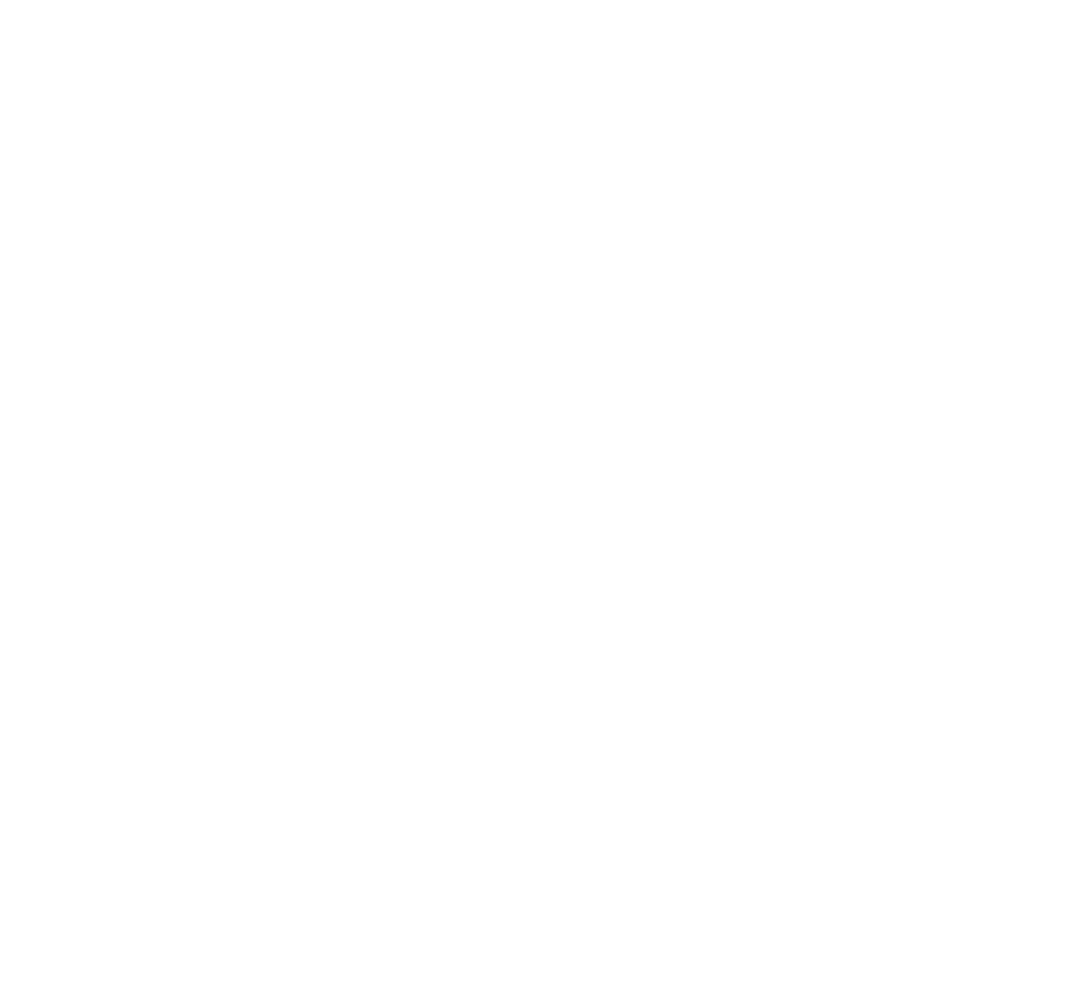
Frontiers in Pharmacology |